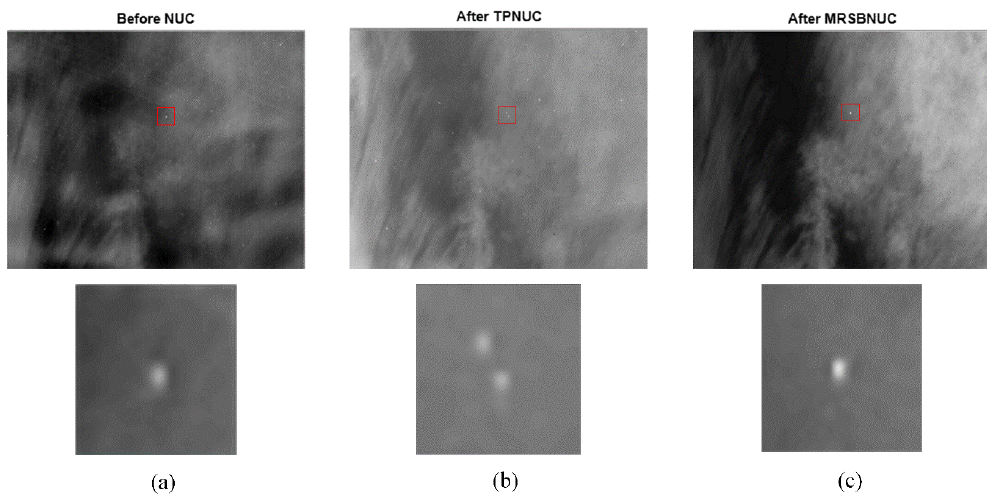
Figure 18. Target 2: ( a ) before NUC, ( b ) after TPNUC and ( c ) after MRSBNUC.